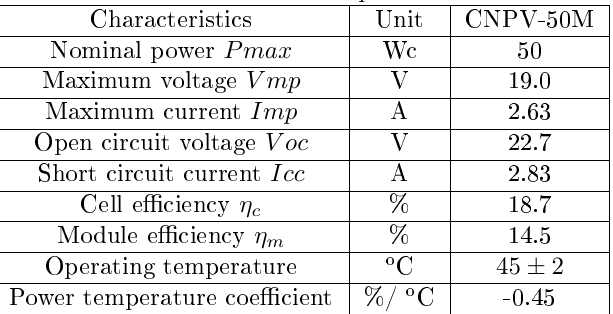
Table 1. Characteristics of the photovoltaic